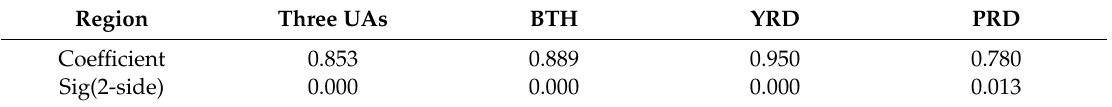
Table 7. The Pearson coe ffi cient between local-MAI and floating population.